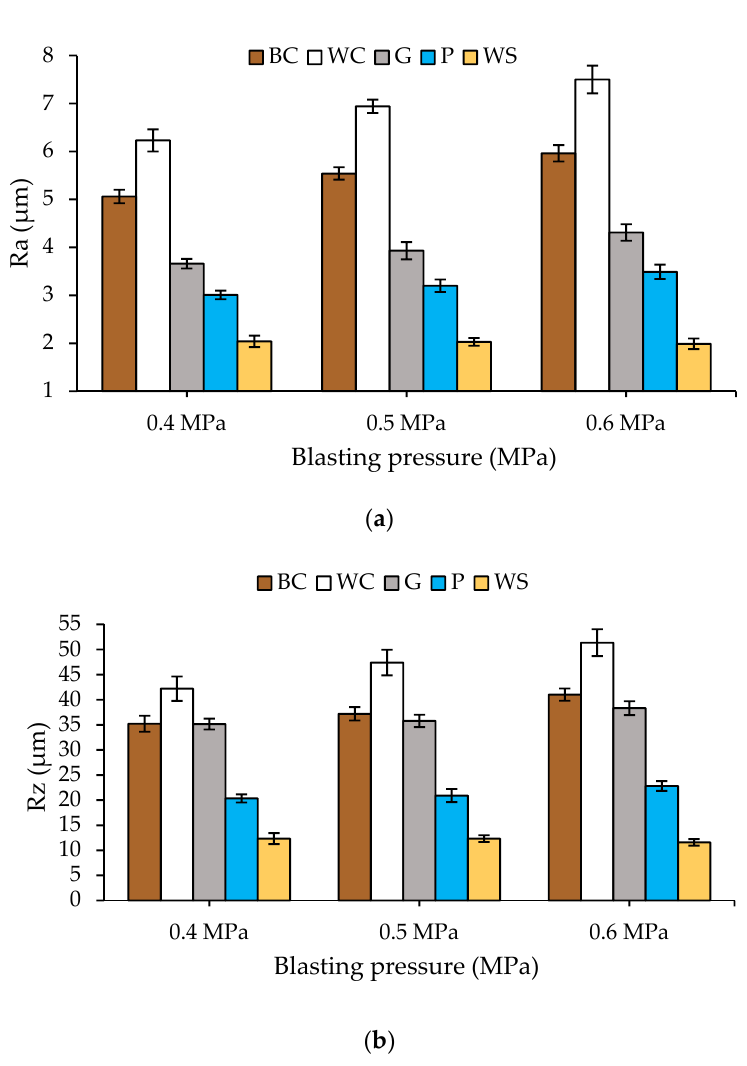
Figure 4. Ra ( a ) and Rz ( b ) values after stripping PTFE coatings on the EN AW 5182 substrates with di ff erent abrasives: (i) BC-brown corundum, (ii) WC-white corundum, (iii) G-glass microspheres, (iv) P-plastic particles, and (v) WS-walnut